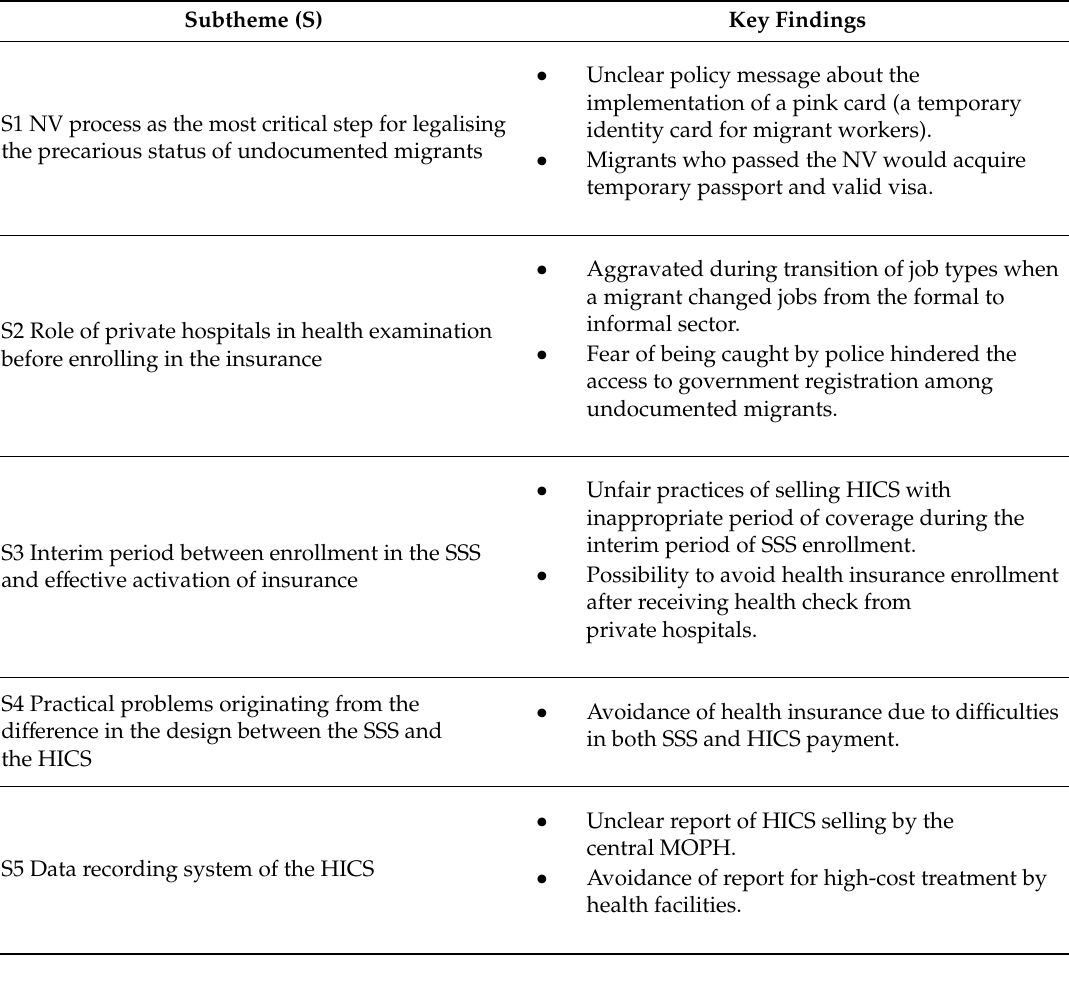
Table 3. Summary of key findings of the